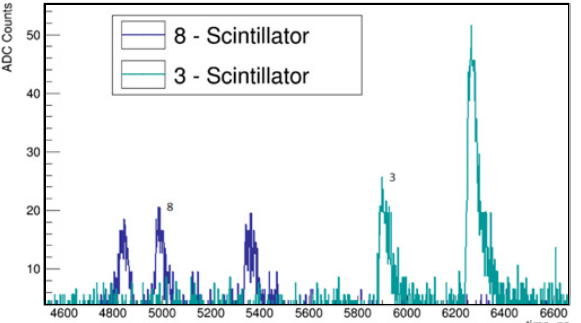
Figure 9. MME as seen by HT detector